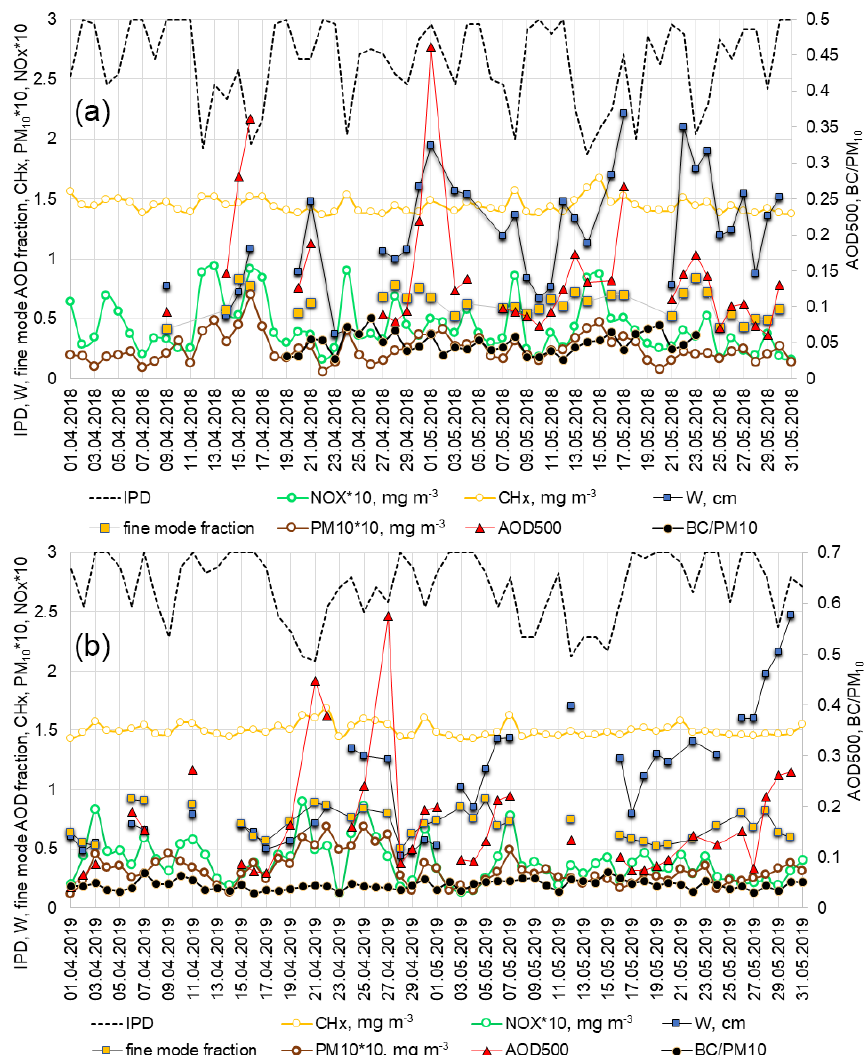
Figure 4. Daily means of AOD500, fine-mode AOD fraction at 500nm, PM 10 (mgm − 3 ) and aerosol gas precursor (NO x , CH x ) mass concentrations (mgm − 3 ), BC / PM 10 ratio, water vapor content (cm) and IPD index in 2018 (a) and 2019 (b)